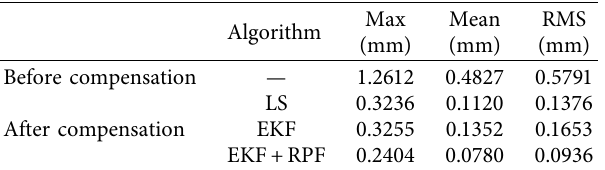
Figure 8: The distance error of the robot after compensation by EKF+RPF. Table 3: The distance error of robot before and after compensation by 3 different